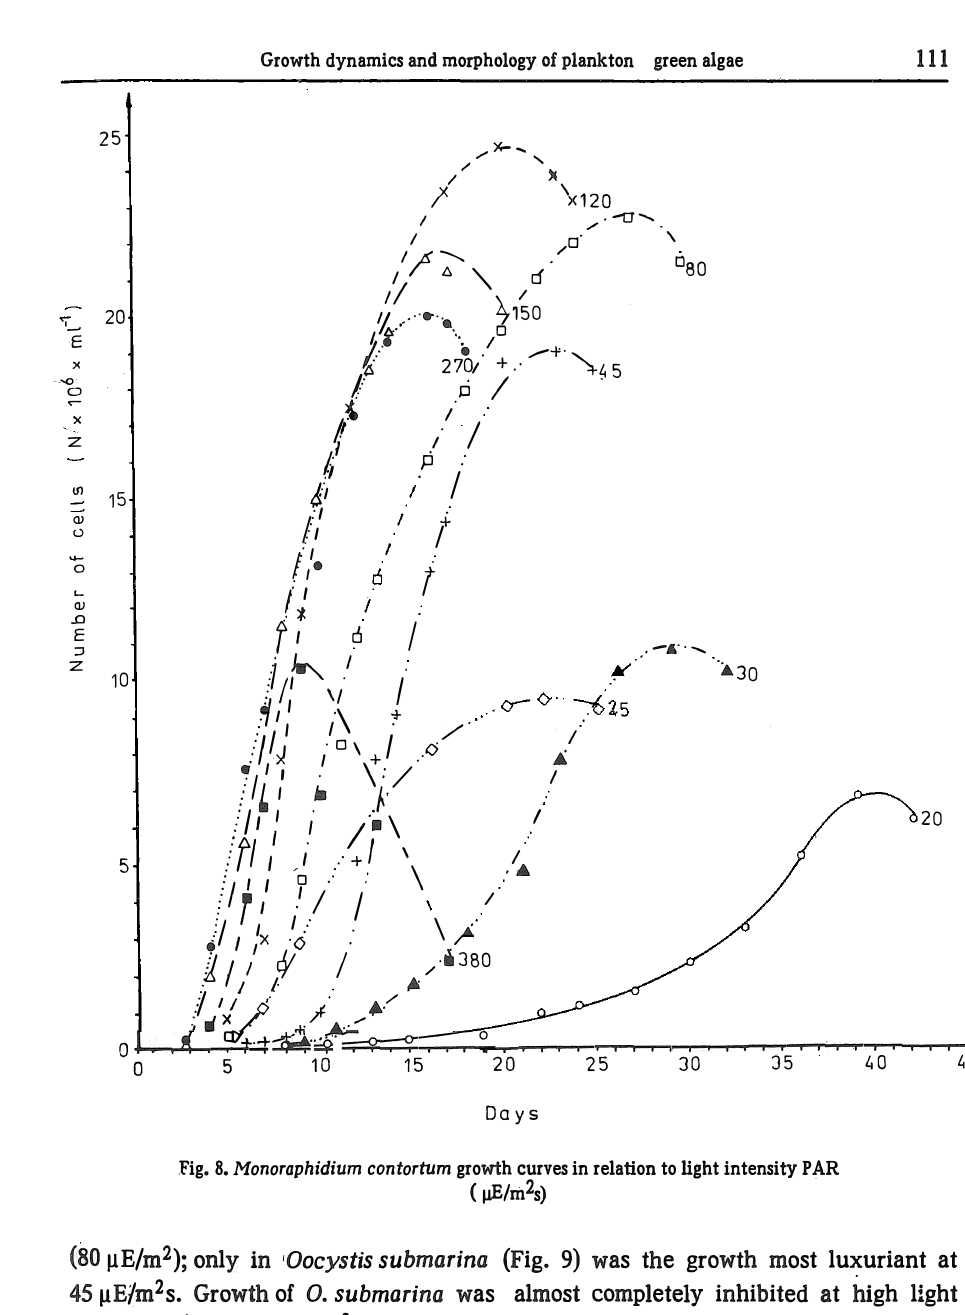
fig. 8. Monoraphidium contortum growth curves in relation to light intensity